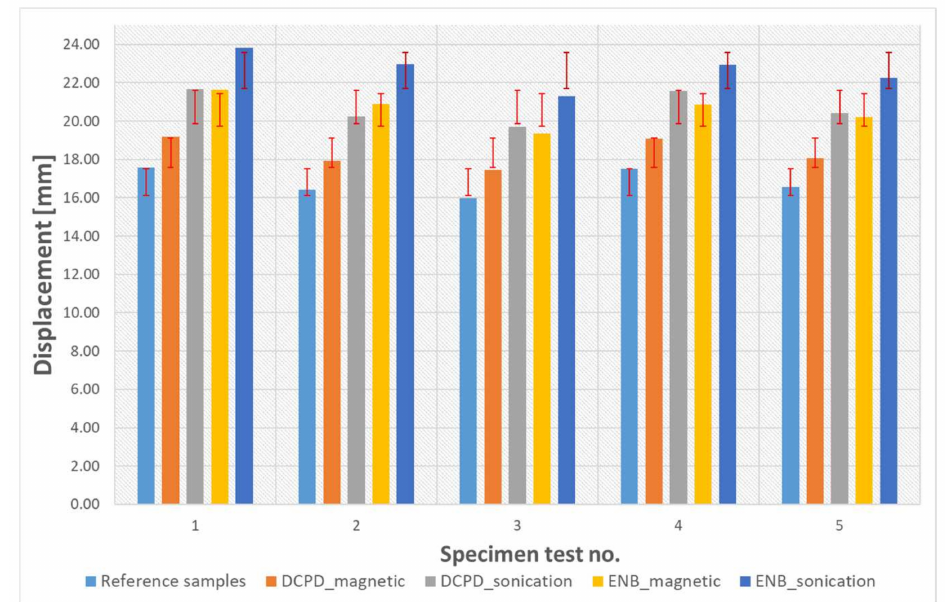
Figure 8. Displacement values for the three-point bending tested specimens.